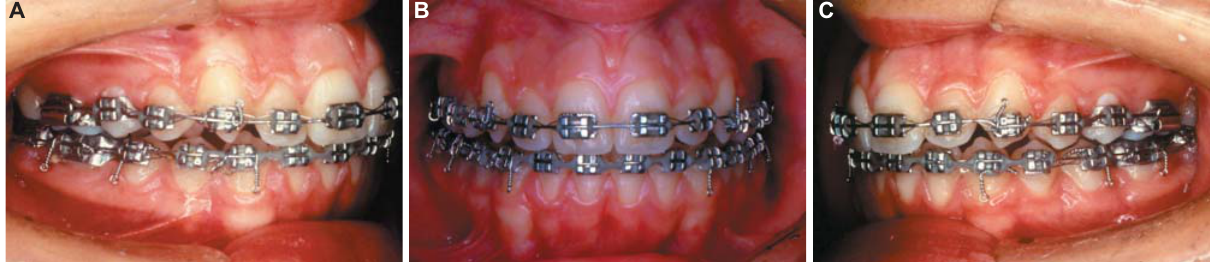
Figure 3- Intraoral aspects. Occlusal view showing the Haas-type expansion appliance installed (A) and the radiographic aspect (B)